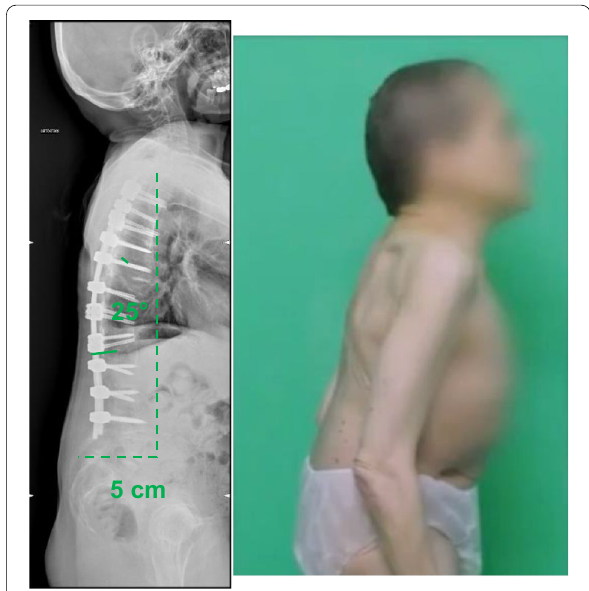
Fig. 9 Case 1: postoperative radiographic and clinical presentation